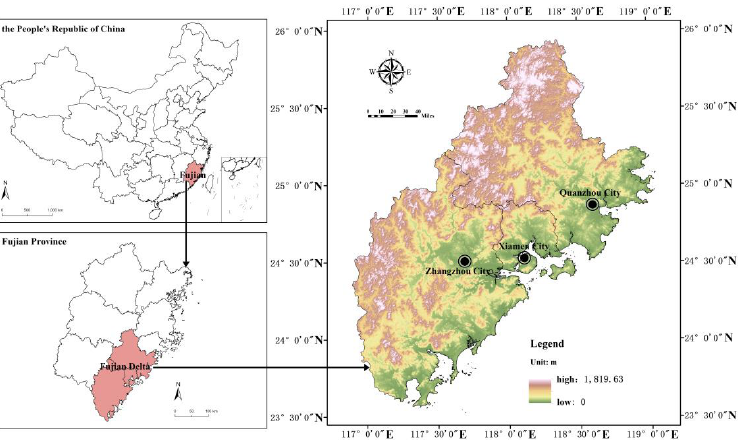
Figure 1. Location and topography of Fujian Delta.